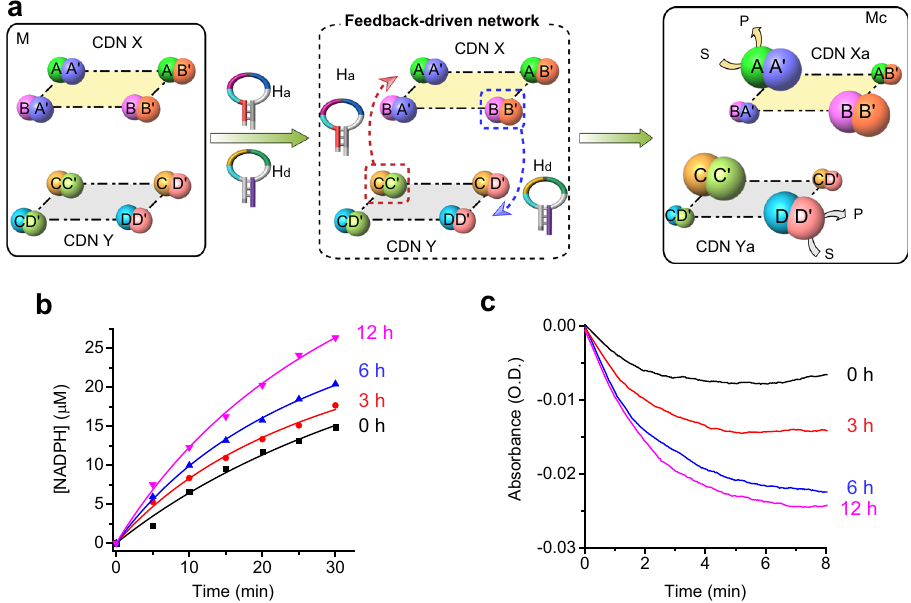
Fig. 4 Integrated feedback-driven intercommunicating networks X and Y using the mixture of stimulants hairpin a (H a ) and hairpin d (H d ). a Subjecting the mixture M to the two stimulants H a and H d results in the state M c , where the H a -triggered time-dependent metabolic network (Y)-driven transition of X into X a and the concomitant H d -triggered time-dependent photosynthetic network (X)-guided transition of constitutional dynamic network CDN Y into Y a occur. S and P represent substrate and product, respectively. b Time-dependent formation of reduced nicotinamide adenine dinucleotide phosphate (NADPH) by the photosynthetic network X at time intervals of activation by stimulant H a -triggered operation of the metabolic network Y. For duplicate results in b , see Supplementary Fig. 34. c Time-dependent operation of metabolic network (followed by the reduction of methylene blue MB + to MBH) at time intervals of H d -triggered operation of the photosynthetic network. N = 2 (for b ) and N = 3 (for c ) independent experiments were performed, respectively. Source data are provided as a Source Data fi